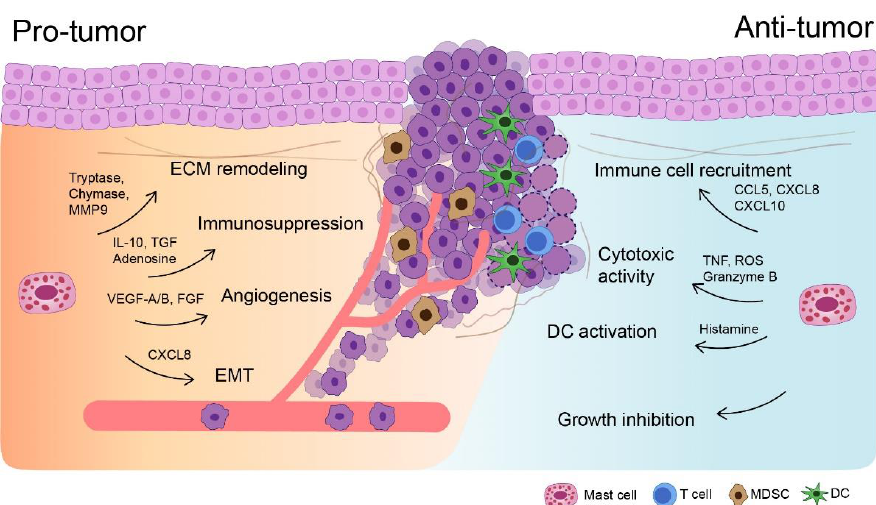
Figure 1. Mast cells (MCs) and their mediators have a pro- or antitumorigenic function in a variety of ways. MCs can mobilize and interact with MDSC and Treg to promote the immunosuppressive tumor microenvironment. Pro-angiogenic factors promote endothelial cell migration, proliferation, and blood vessel development. The release of proteases liberates growth factors bound to the extracellular matrix (ECM) to stimulate fibroblast proliferation and angiogenesis and that breakdown the ECM, thus facilitating tumor cell invasion. MCs can exert antitumor action through direct cyto-toxicity of tumor cells. MCs also serve as sentinels, secreting a variety of chemokines that facilitate the recruitment of anti-tumor immune effector cells to tumor locations and regulate immune effector cell responses. EMT: epithelial-to-mesenchymal transition, DC: dendritic